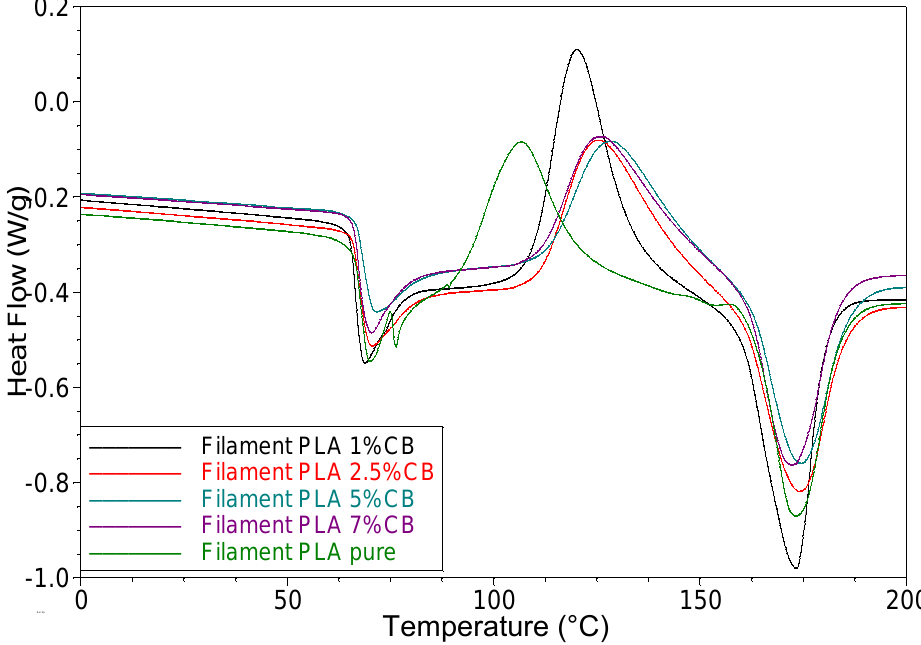
Figure 9. DSC curves of the unfilled PLA filament and the filled composite filaments: PLA + 1 vol.% CB; PLA + 2.5 vol.% CB; PLA + 5 vol.% CB and PLA + 7 vol.% CB. The numbers near the curves indicate the content of CB in composites.